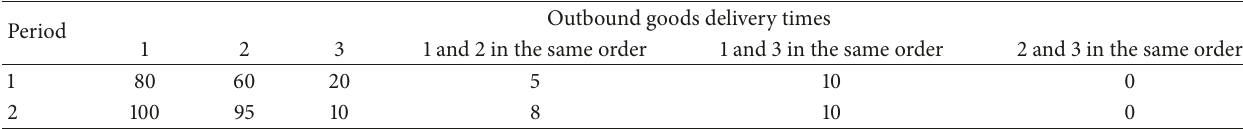
Table 1: Sample outbound goods delivery